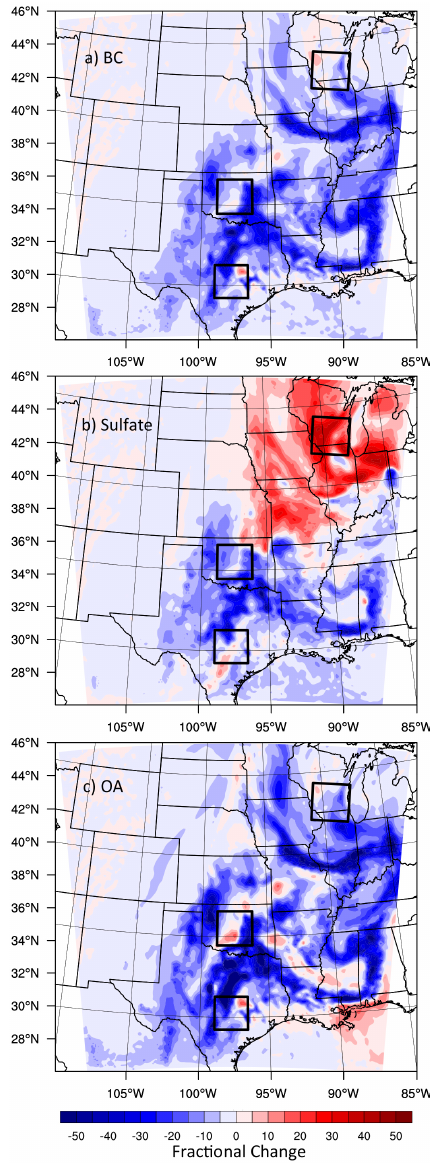
Figure 9. Fractional differences in column-integrated aerosol mass loading between DeepShallow and Control simulations for size bins 1 through 4, including both interstitial and activated aerosol in the cloudy grid cells, for BC (a) , sulfate (b) and OA (c) , valid at 20:00UTC on 25 June 2007. Black boxes indicate boxes used in the